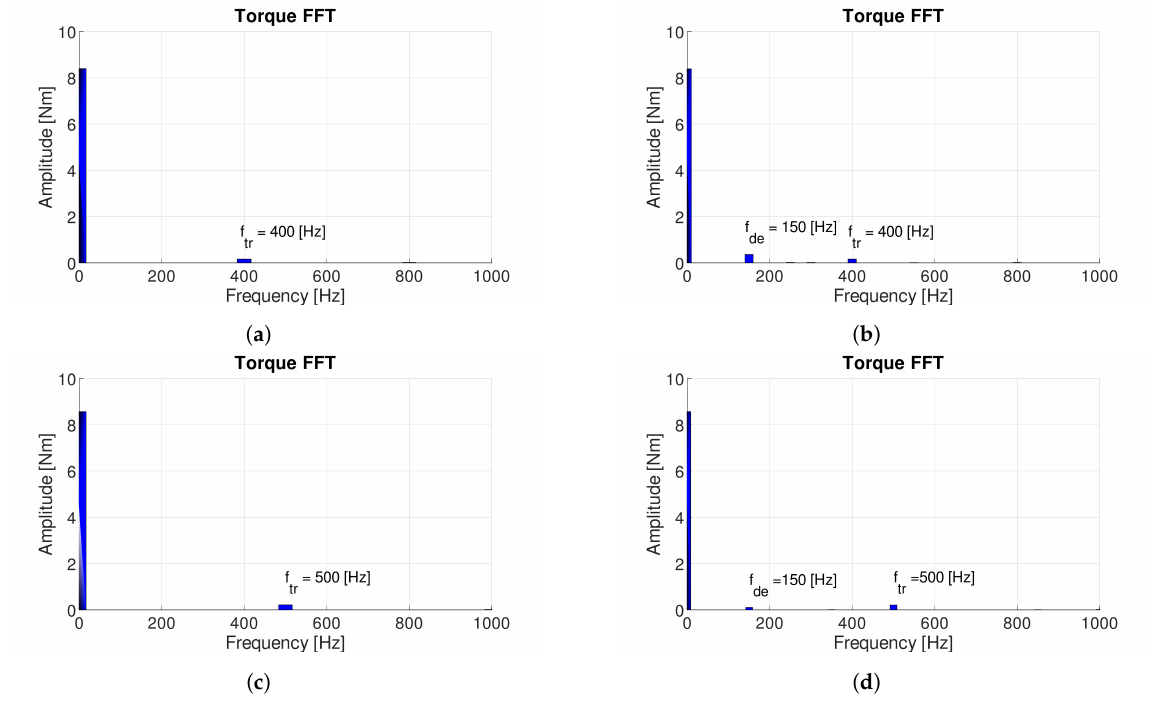
Figure 6. FFT of the mean torque of 9-8DL and 9-10DL without and with dynamic eccentricity of 0.2 mm. ( a ) 9-8DL without defect; ( b ) 9-8DL with dynamic eccentricity; ( c ) 9-10DL without imperfection; and ( d ) 9-10DL with